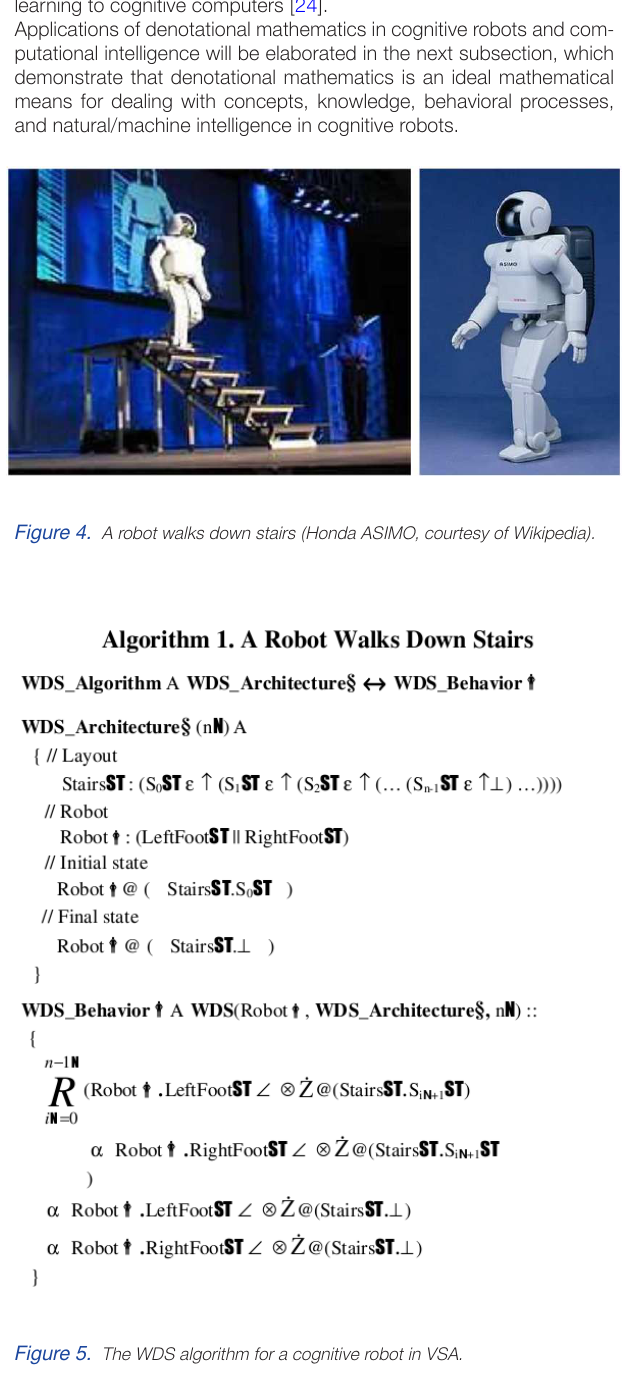
Figure 5. The WDS algorithm for a cognitive robot in